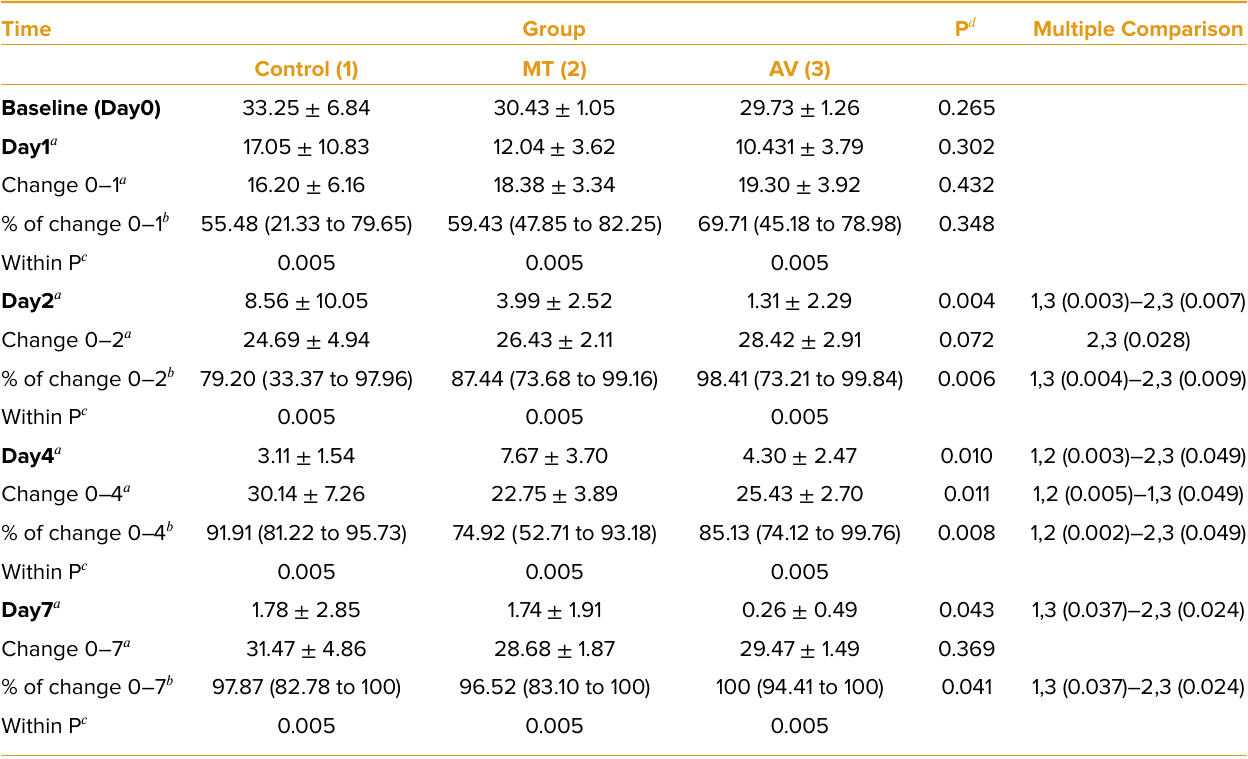
Table 2. Comparison of the mean area of the corneal epithelial defect (CED) among the Aloe Vera (AV), medical therapy (MT), and control groups at the baseline and on days 2, 4, and 7, as well as the changes of CED areas over the seven-day